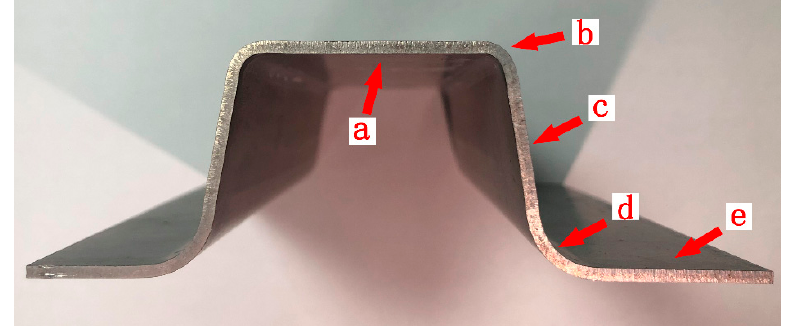
Figure 9. Thickness measurement position.